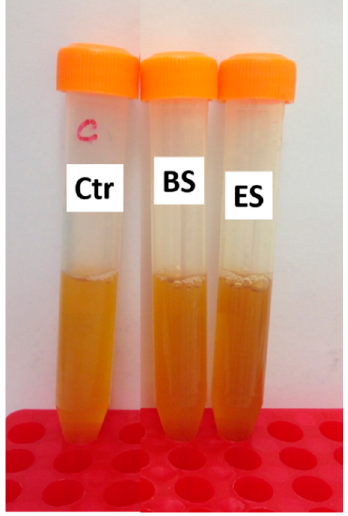
Figure 3. Comparison of the juice transmittance in the visible region immediately and 7 days post plasma exposure (+ 7 days) in the electrospray system (ES) and the batch system (BS).